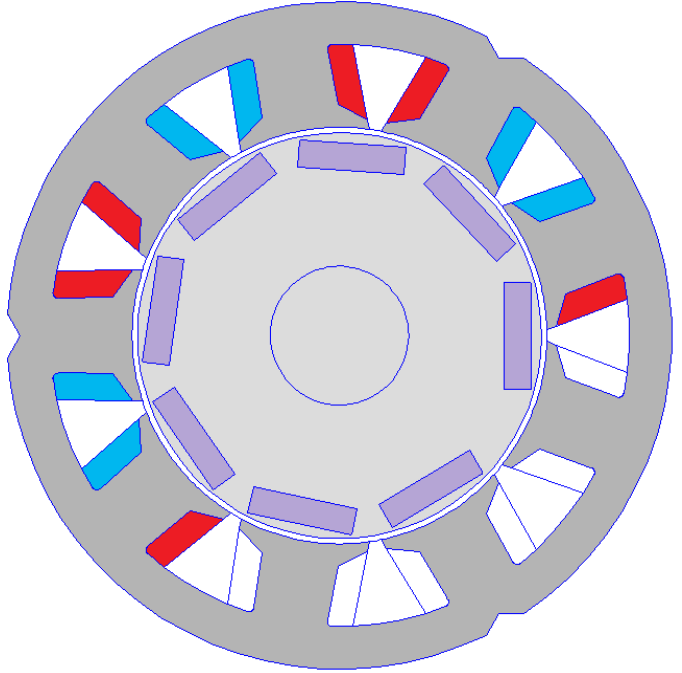
Figure 4. DCPM motor and stator’s segment with coils added.